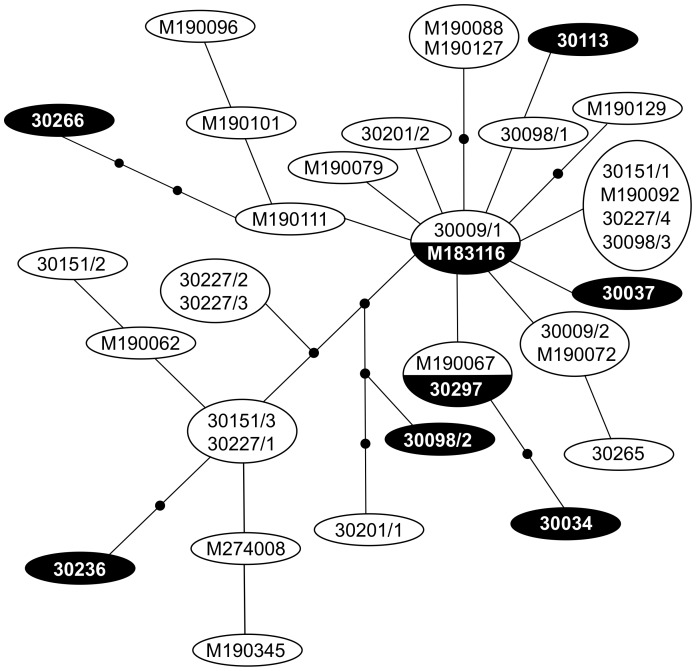
Haplotype network (based on 573 bp of mtDNA nad2) of 27 Alcithoe wilsonae (open ovals) and 8 Alcithoe knoxi (filled ovals) demonstrates the lack of genetic structure related to morphology.Each haplotype differs by a single nucleotide, unsampled haplotypes are represented by black dots. (See Table 1 for sample codes.).